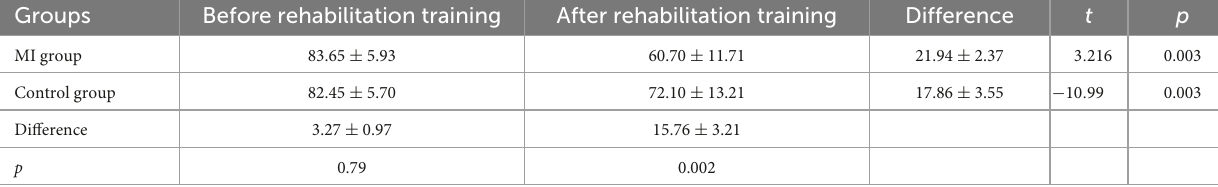
TABLE 4 Comparison of the affected brain NCCT between the MI and control group. Groups Before rehabilitation